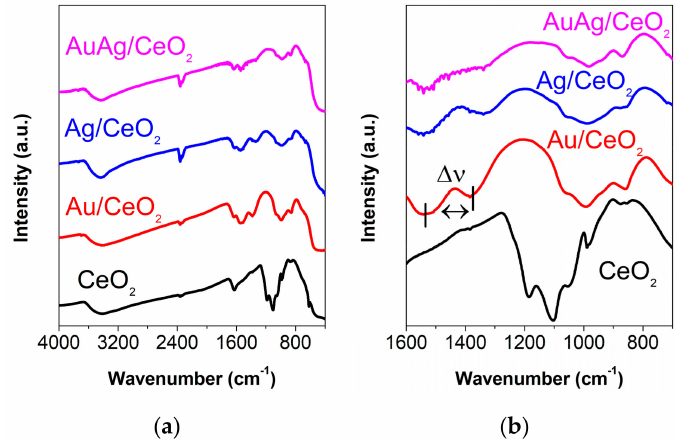
Figure 4. ( a ) Fourier Transform Infrared pectra of the investigated catalysts; ( b ) zoom on the “carbonate”